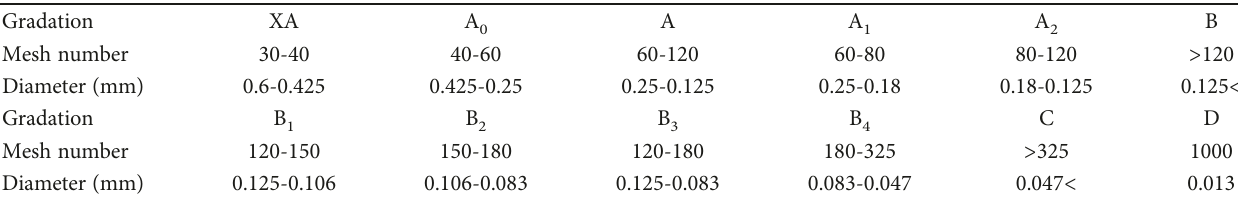
Table 3: The size distribution of particles used in the